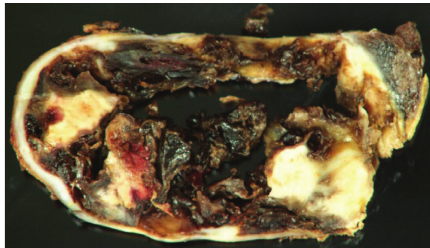
Figure 3: Gross pathology images show cystic hemorrhagic mass, due to